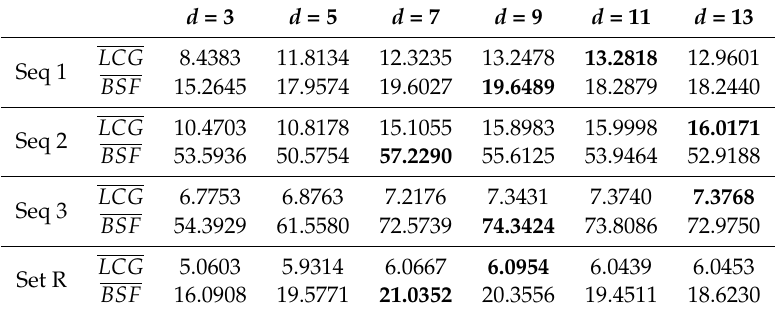
Table 1. Average background suppression factor (BSF) and local contrast gain (LCG) of the three sequences and Set R processed by the proposed modified random walks (MRW)-based small target detection algorithm with variation of the sub-patch size d